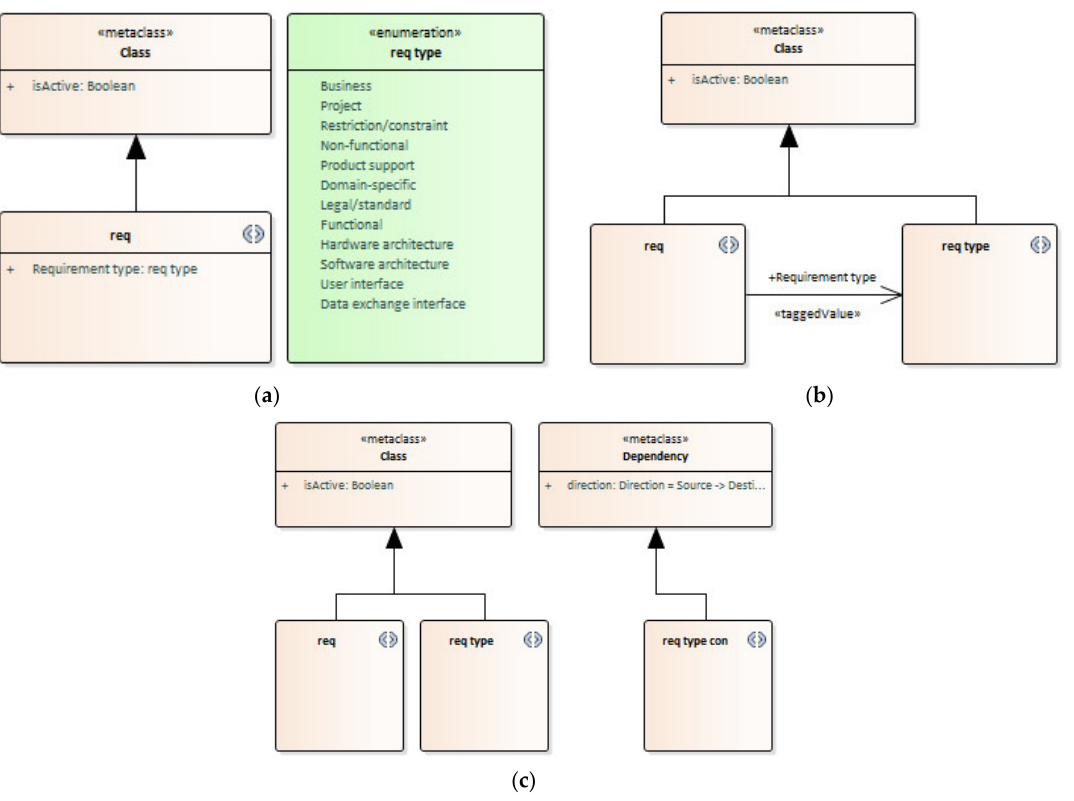
Figure 7. Two approaches to the language design. First approach: ( a ) semantic artefacts completely defined at M2 level; Second approach: ( b ) semantic artefacts to be created at level M1 with directed relationship; ( c ) semantic artefacts to be created at level M1 with bi-directional relationship.